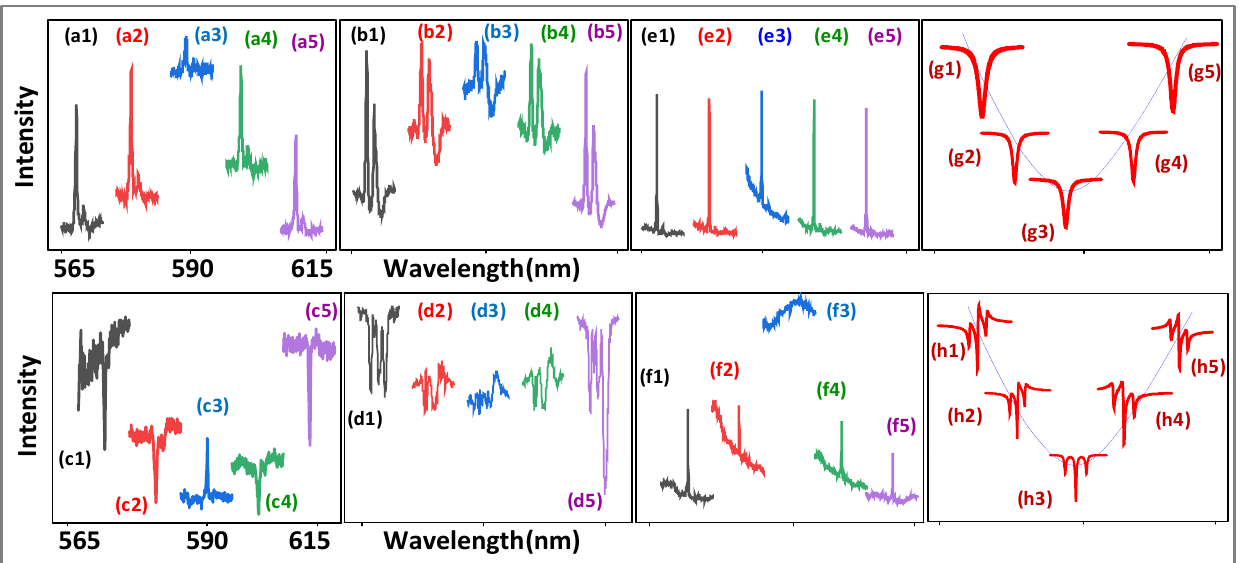
Figure 5. ( a , c ) show SFWM cross- interaction observed from Eu 3+ doped in molar ratio (6:1) BiPO 4 at different E 1 wavelengths (567.4 nm, 584.4 nm, 588.4 nm, 596.4 nm, 612.4 nm) and E 2 scanned from 567.4 nm to 607.4 nm at PMT1 and PMT2 at 300 K, respectively. ( b , d ) show SFWM cross- interaction at different E 2 wavelengths (567.4 nm, 587.4 nm, 588 nm, 588.4 nm, 602.4 nm) and E 1 scanned from 567.4 nm to 612.4 nm at PMT1 and PMT2 in 300 K, respectively. ( e , f ) show SFWM cross-interaction at 77 K. The other experimental conditions are the same as ( a , c ), respectively. Time gate = 500 µ s. ( g1 – g5 ) show the simulation result corresponding to ( b1 – b5 ). ( h1 – h5 ) show the simulation result corresponding to Figure 3(g1–g5) and Figure 7(e1–e5).